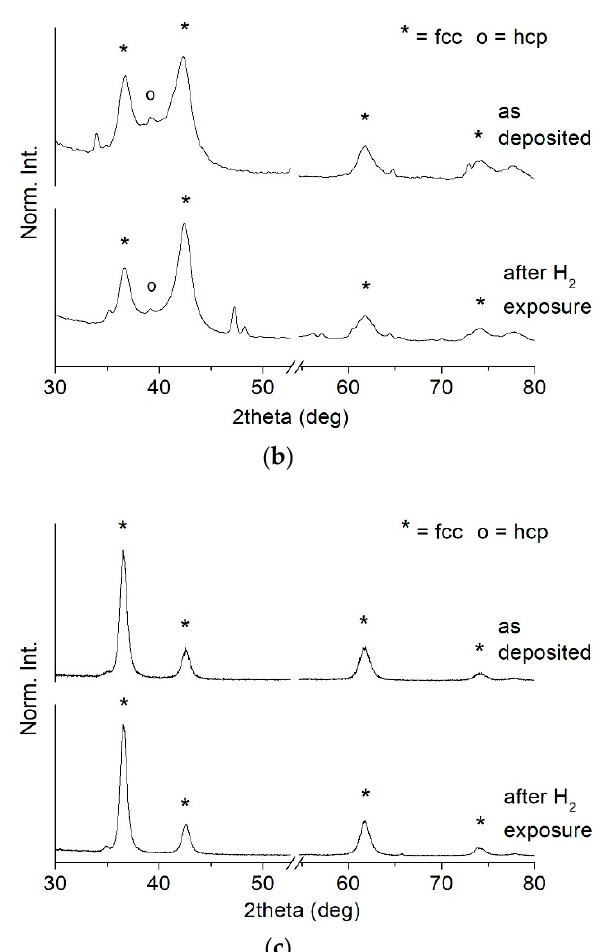
Figure 9. XRD spectra of samples ( a ) TiN2, ( b ) TiN3 and ( c ) TiN4 before and after thermal treatment at 500 °C under H 2 -containig atmosphere for 20 h.